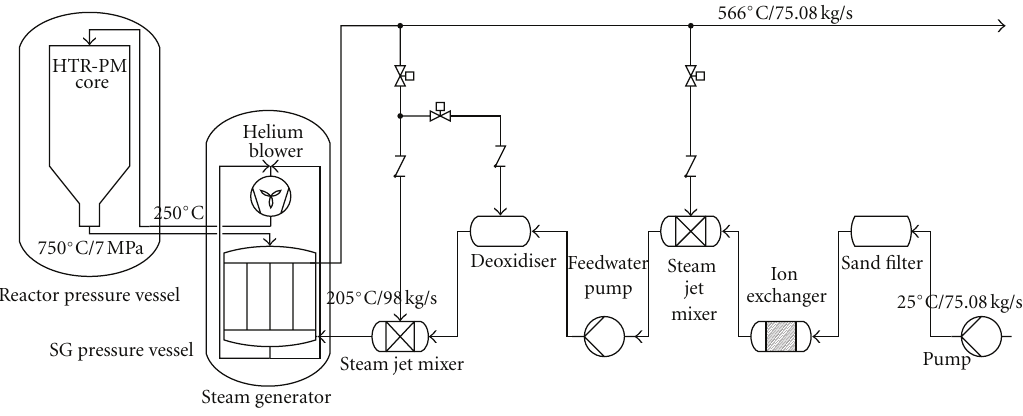
Figure 4: Modified design of HTR-PM for thermal